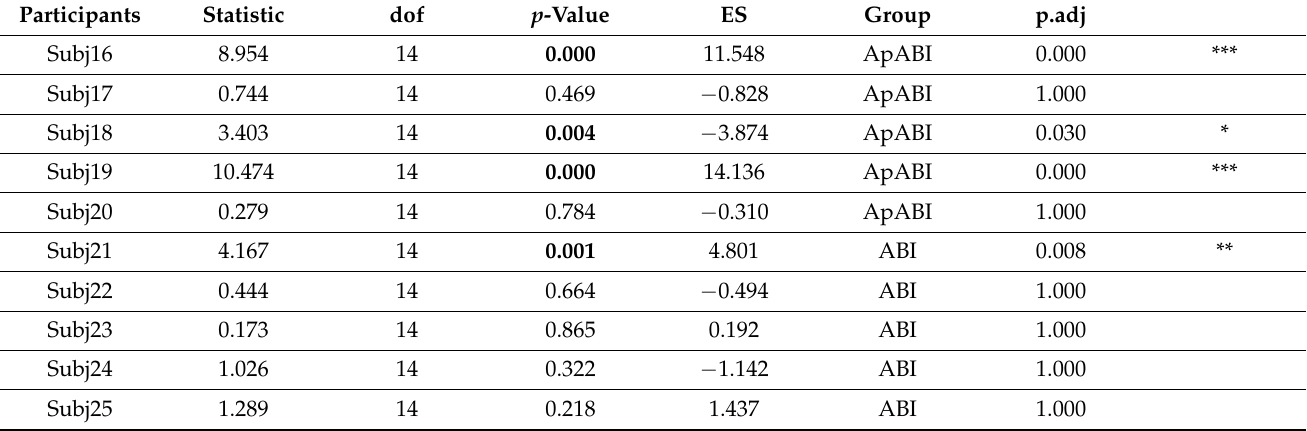
Table 8. Patients’ performance in H-FT.